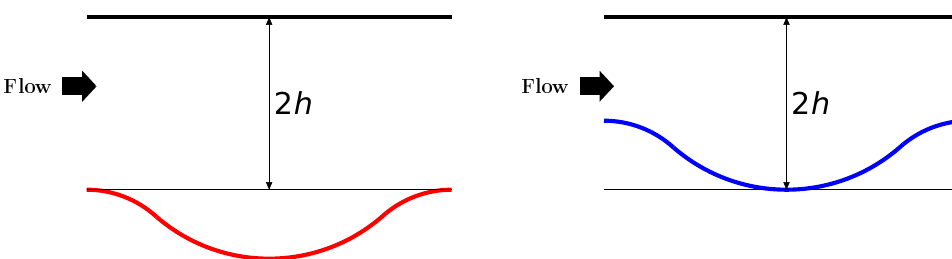
Figure 8. A dimpled wall and two different, equivalent flat channels. The red/blue lines indicate the dimple profile. Left : the channel height 2 h goes from the top wall to the dimple tip; right : the channel height 2 h goes from the top wall to the dimple lowest